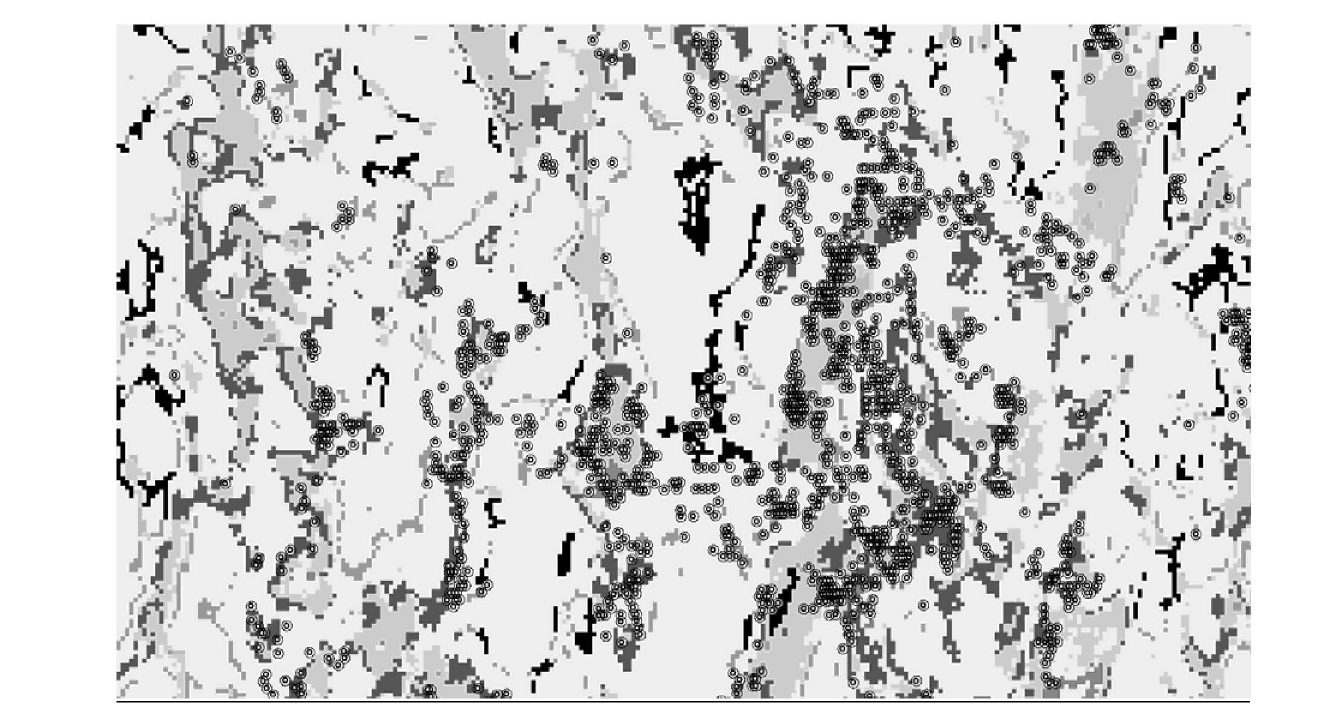
Fig. 1. GPS positioner för får i högfjället. Små prickar (cirklar) är telemetripositioner (GPS) för får, cirkeln omkring har 6.5m radie från den angivna positionen (95% av alla verkliga positioner ligger inom 6.5 m från den angivna positionen.Vit färg på kartan är lavmark, ljus grå är gräsdominerad vegetation, mörkgra är buskmark och svart är rished. Data från Hessdalen, Sør-Trøndelag.